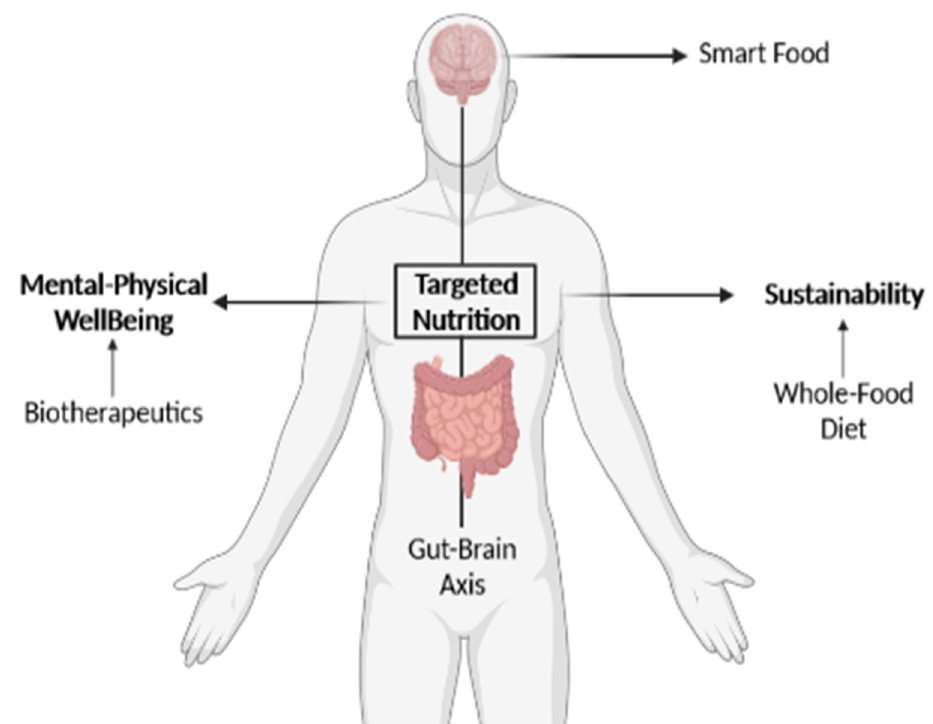
Figure 3. Targeted nutrition as a science-driven solution that directly addresses the SDGs “Good Health and Well-Being” and “Responsible Consumption and Production”. The conceptual representation of the beneficial effects of promoting a healthy, personalized, and sustainable diet targeting the microbiota–gut–brain axis to promote mental wellness (or smart food ). Created with BioRender.com (accessed on 20 July 2021).